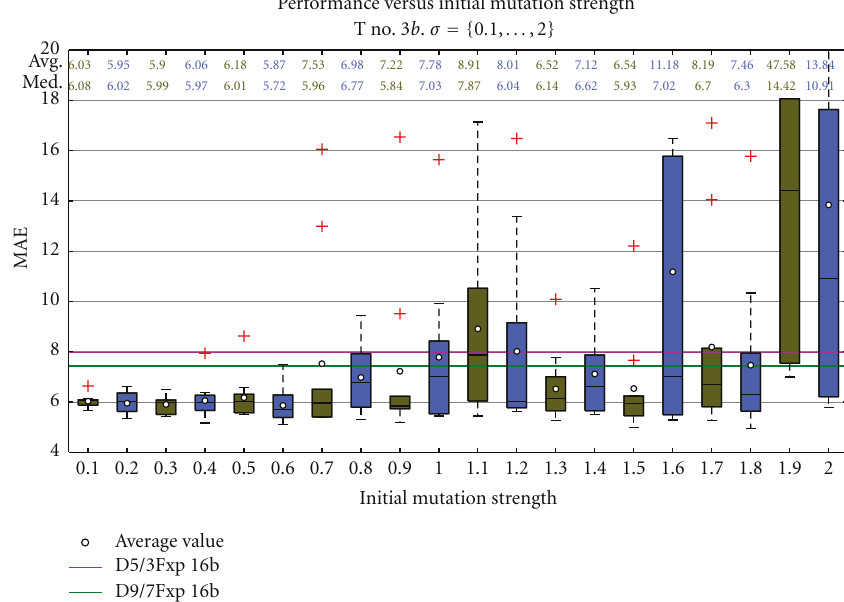
Figure 7: Test no. 3 b.